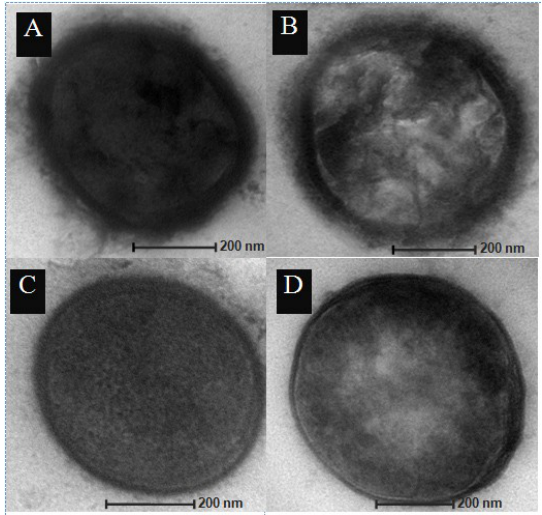
Figure 1. Detection of capsule by transmission electron microscope (TEM). ( A ) wild-type parental D39 strain; ( B ) SPE strain; ( C ) SPC strain; ( D ) SPEC strain.